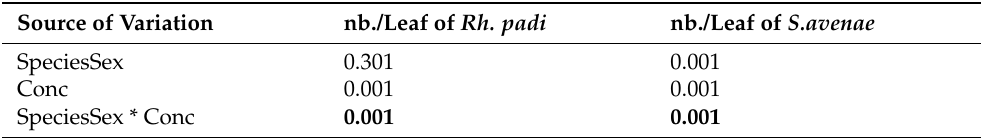
Table 5. ANOVA p -values that show the significance of the main effects and the interaction effect of species-sex and concentration (Conc) on nb./leaf of Rhopalosiphum padi and nb./leaf of Sitobion avenae for repellent